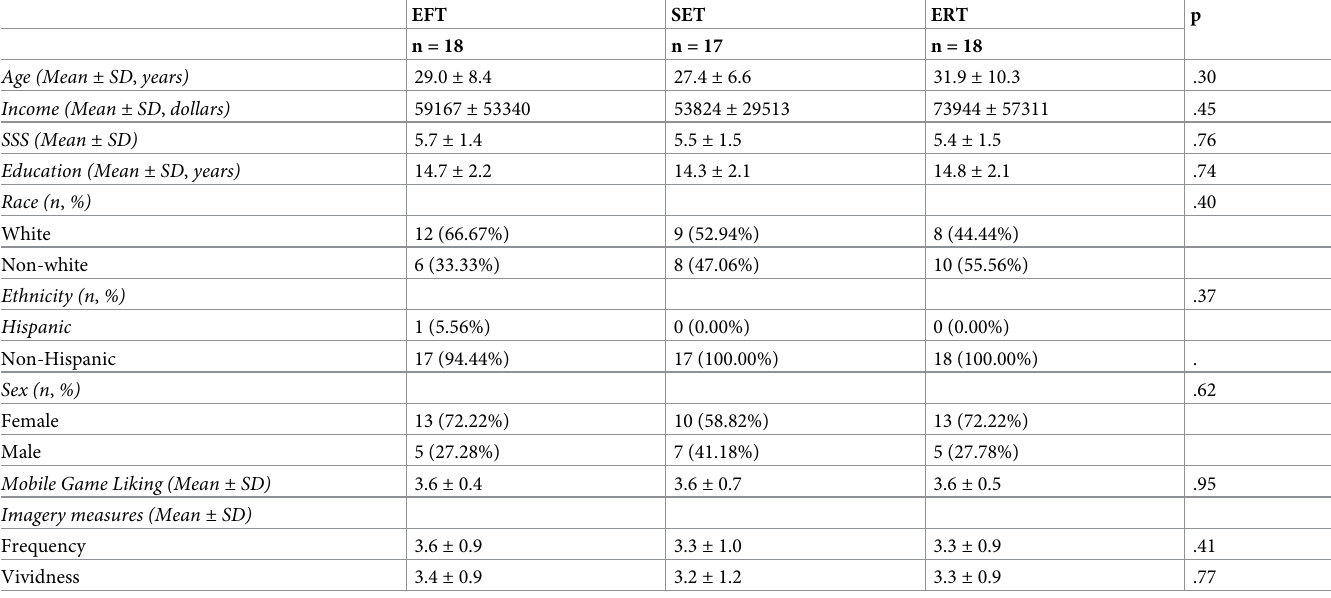
Table 2. Participant